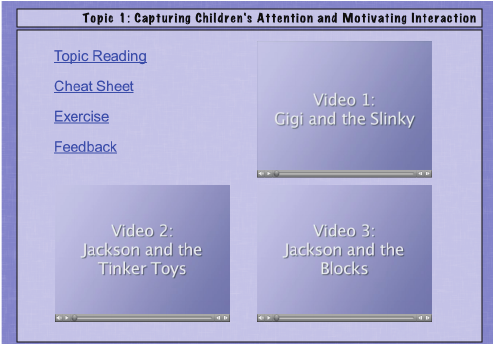
Figure 1: Screen shot of topic one from the ESDM learning module